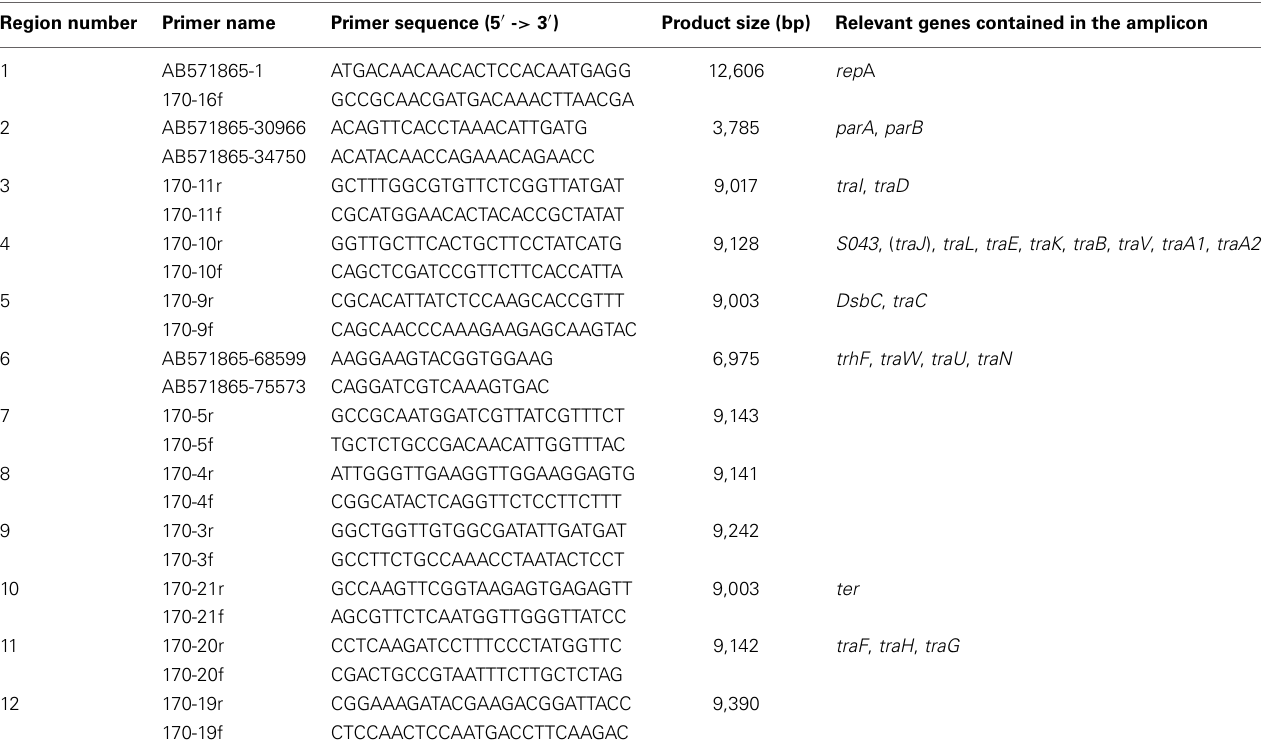
Table 2 | PCR primers for detection of the conserved region between pAQU1 and pAQU2 (pAQU backbone). Region number Primer